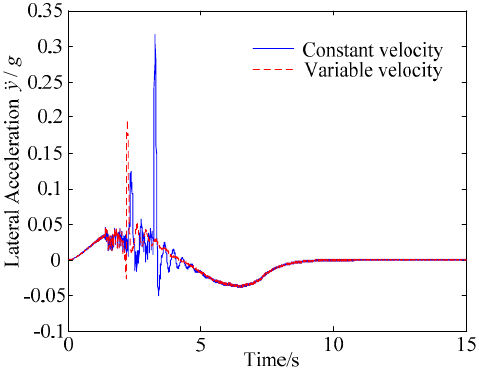
Figure 32. Lateral acceleration of vehicle p under different velocities of vehicle q .